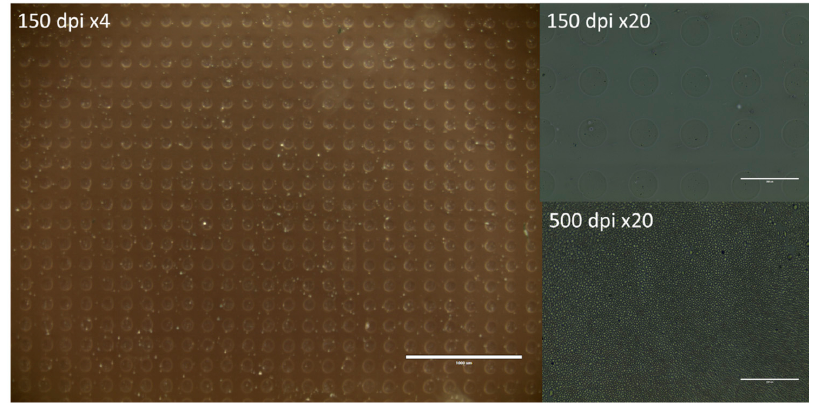
Figure 5. Light microscopy images of MSN–PEI 1 mg/mL suspensions printed with resolutions 150